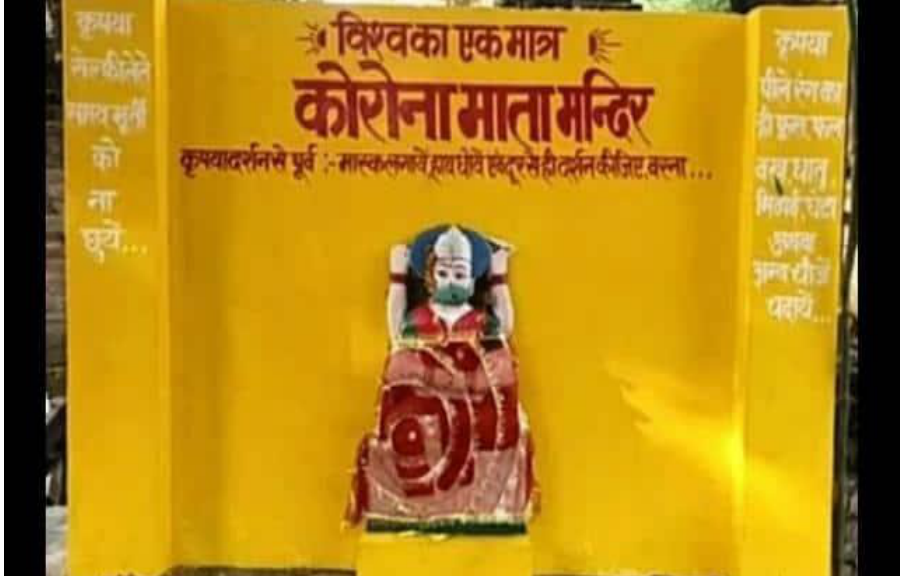
Figure 3. Corona M¯at¯a shrine, Pratapgarh, Uttar Pradesh. Published with the photographer’s Figure 3. Corona Mātā shrine, Pratapgarh, Uttar Pradesh. Published with the photographer’s per- mission.